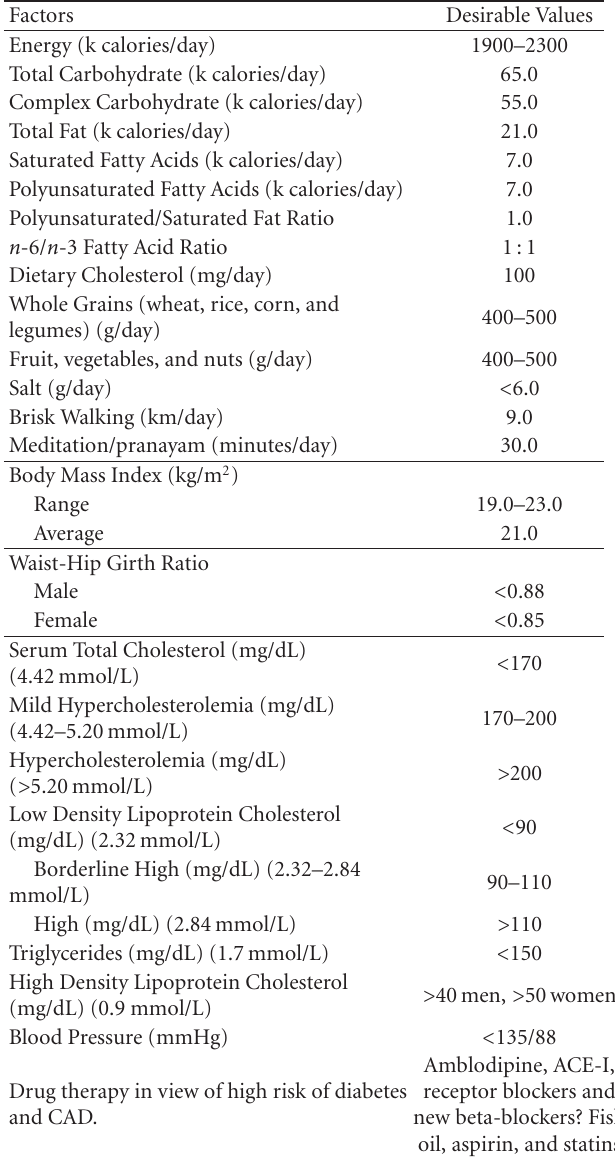
Table 6: Dietary guidelines and desirable level of risk factors for